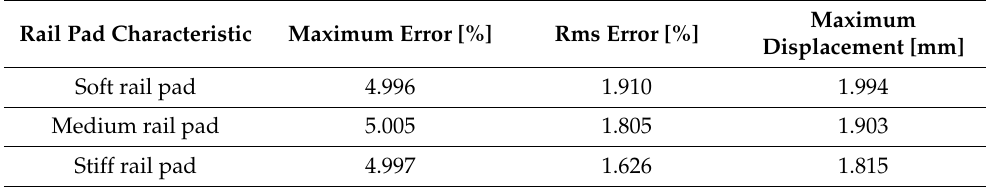
Figure 9. Equivalent characteristics of the track. Table 2. Range of applicability and the errors of the bilinear approximation.